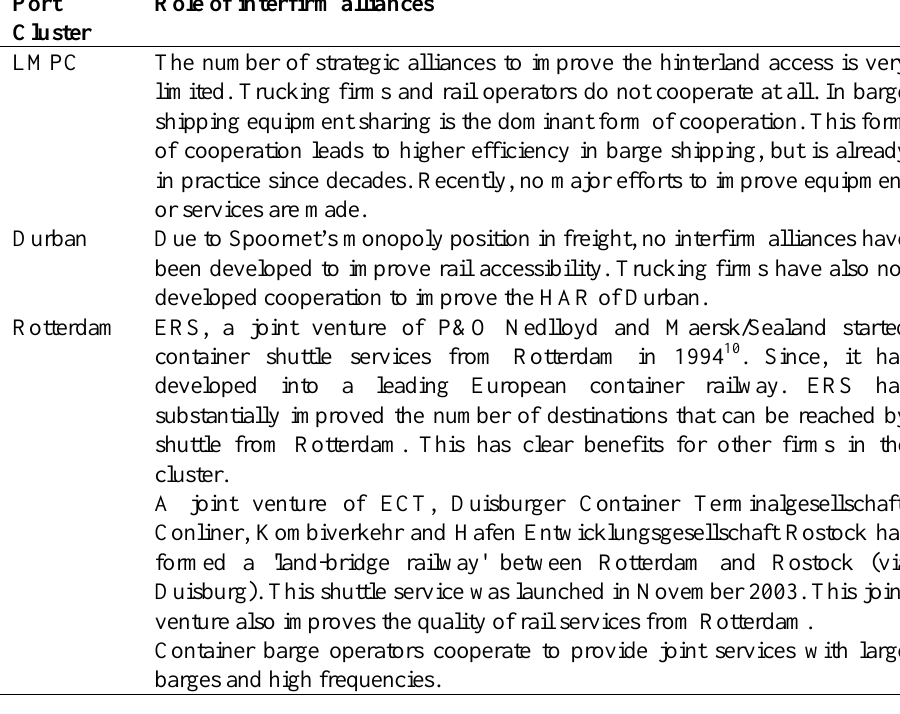
Table 9. The roles of interfirm alliances in the HAR’s of the LMPC, Durban and